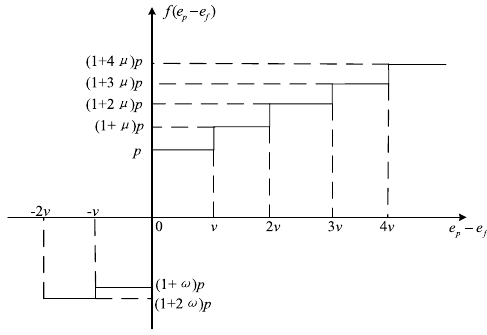
Figure 4. The relationship between carbon trading price and carbon trading